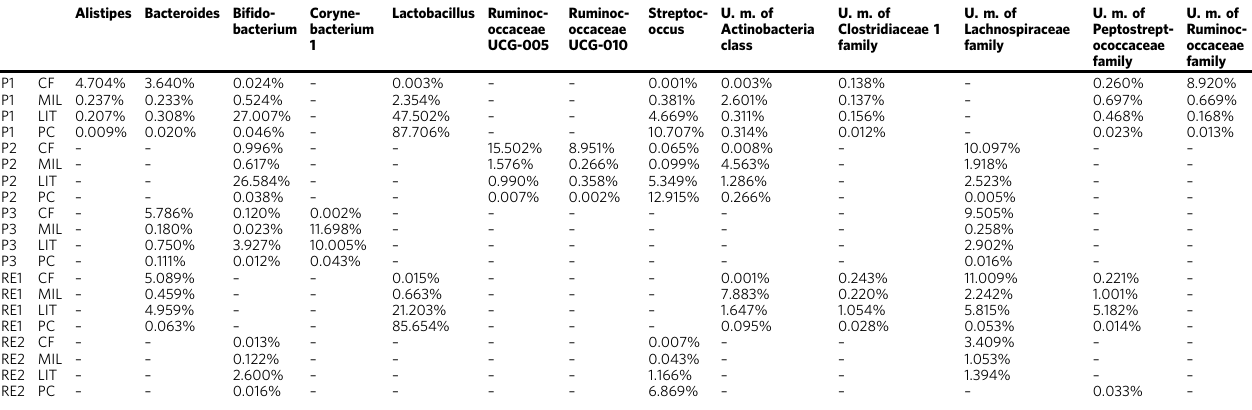
Table 1 Average relative abundance of taxa with a prevalence of >70% in at least three